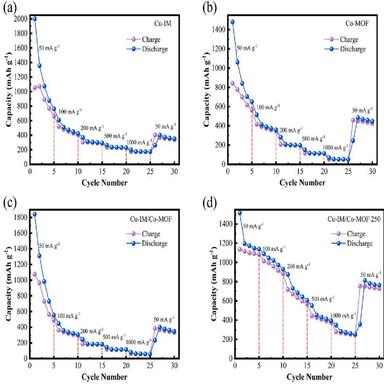
Rate capability at different current densities for (a)Cu-IM, (b)Co-MOF, (c)Cu-IM/Co-MOF, (d)Cu-IM/Co-MOF 250.